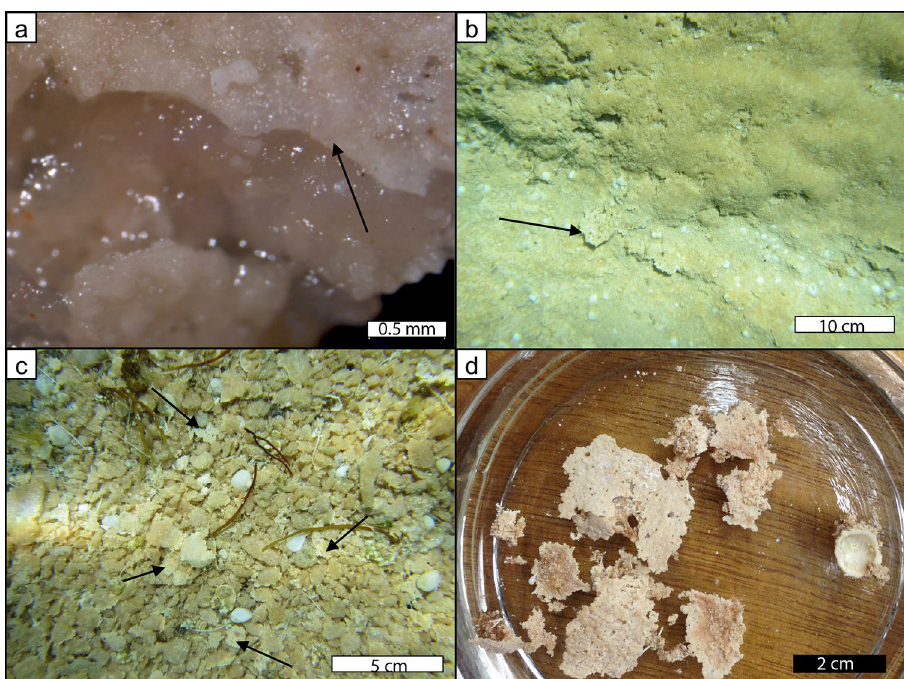
Figure 6. Erosion of gel mats colonizing the surface of low-relief microbial pavements showing irregular micritic grain production. ( a ) micritic crust (arrow) with gelatinous mat underneath; ( b ) platy micritic crusts (arrow) under partially eroded gel mats on top of subtidal low-relief microbial pavement in the Booldah Province; ( c ) detached, eroded globs of gel mat, some with attached crusts (arrows); ( d ) platy crusts from eroded globs of gel mat after organics were removed with